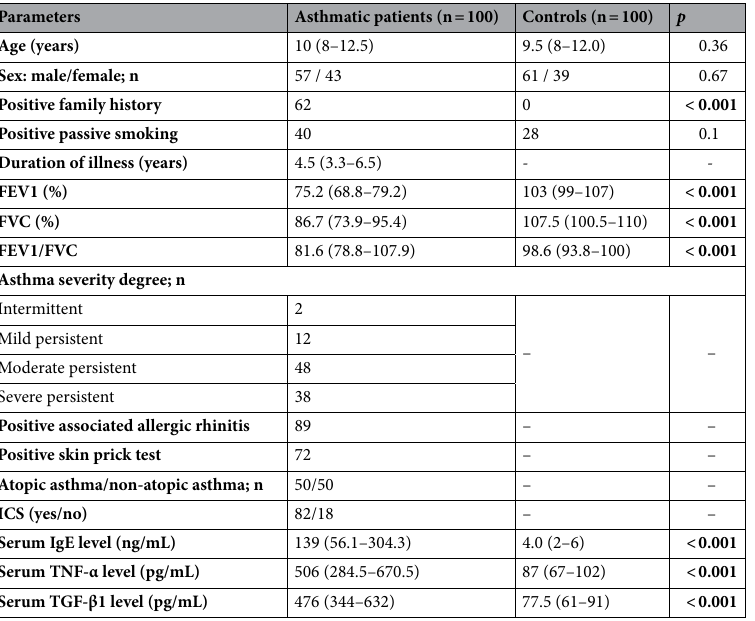
Table 1. Demographic, clinical and biochemical data of the studied groups. Data are presented as numbers with percentages or median with interquartile range. Chi square and Mann–Whitney U tests were applied. FEV1 forced expiratory volume, FVC forced vital capacity, ICS inhaled corticosteroids, IgE immunoglobulin E, TNF-α tumor necrosis factor-alpha, TGF-β1 transforming growth factor-beta 1, IQR interquartile range, n number of patients, p probability, probability value was considered significant at p <